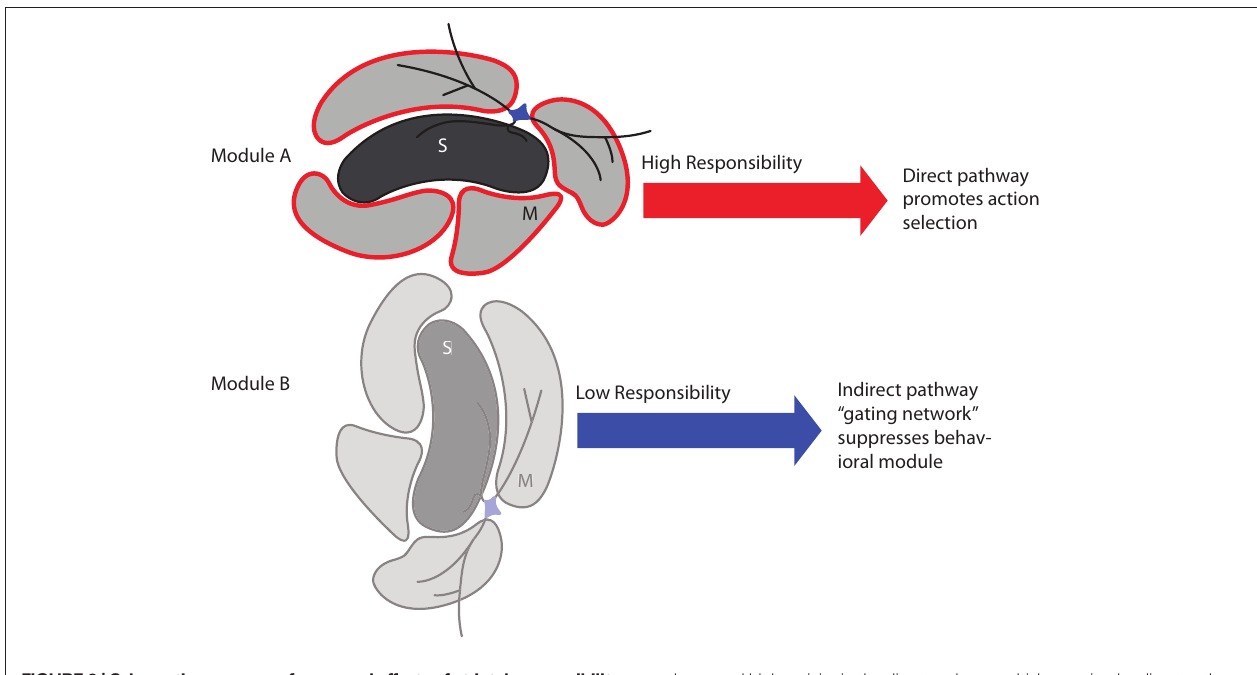
Figure 8 | Schematic summary of proposed effects of striatal responsibility signals on module and action selection. Top: If the sets of actions influenced by module A are appropriate to the environmental context, its striosome (S) assigns high responsibility by sending a signal to adjacent matrisomes (M) via local circuit interneurons. This results in relatively low activity in the indirect